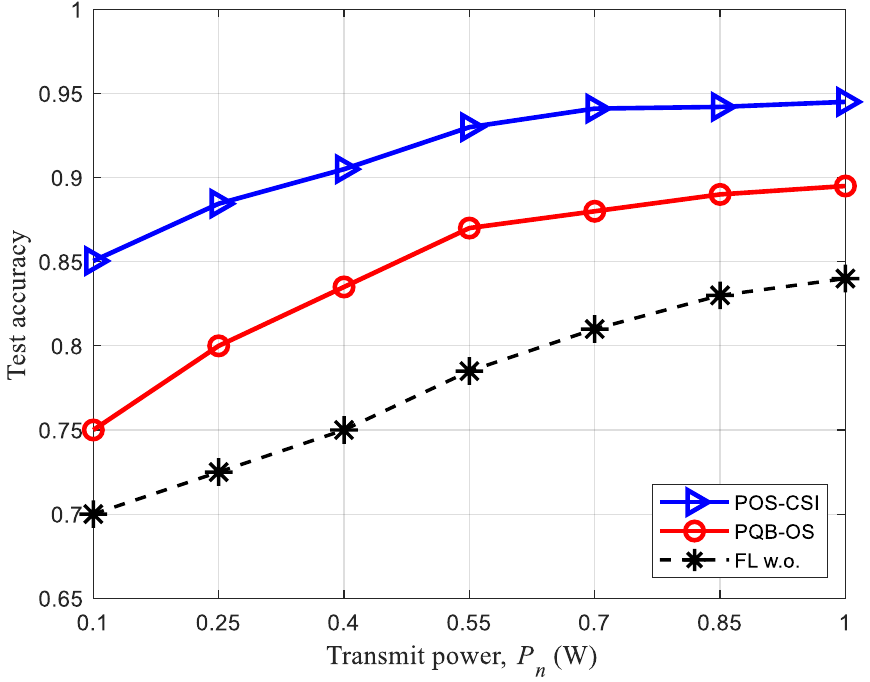
Figure 8. Test accuracy performance of different schemes with different power P n with MNIST dataset for non-IID data distribution, when ∆ T = 50 s, B n = 1 MHz, and D n =